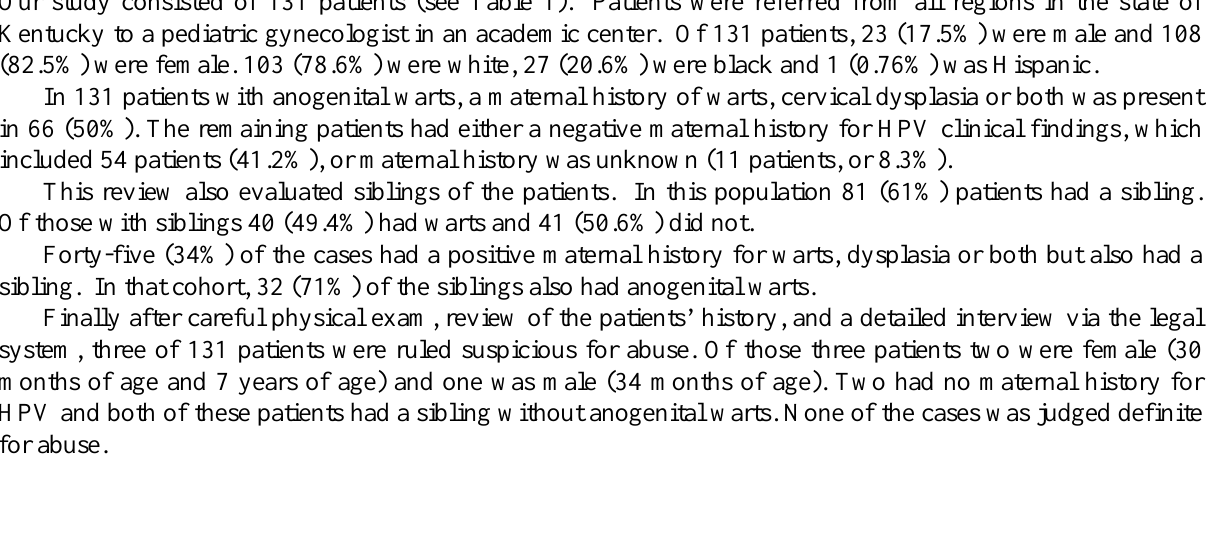
Table 1. Characteristics of the Patient